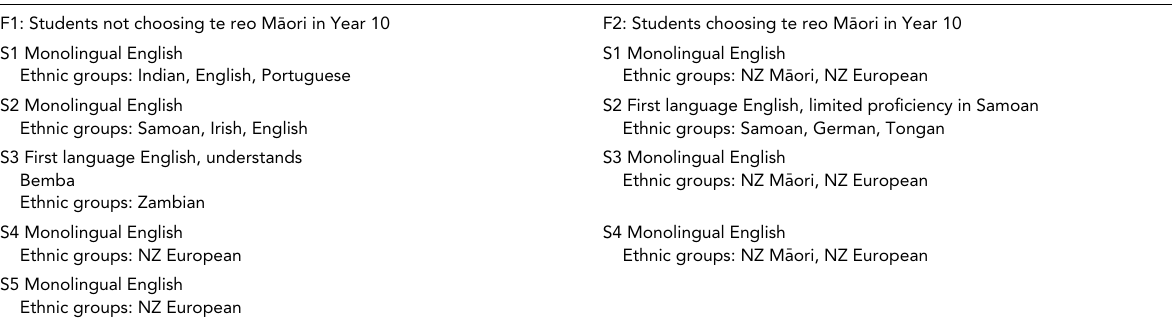
Linguistic and Cultural Backgrounds of Focus Group Participants F1: Students not choosing te reo M¯aori in Year 10 F2: Students choosing te reo M¯aori in Year